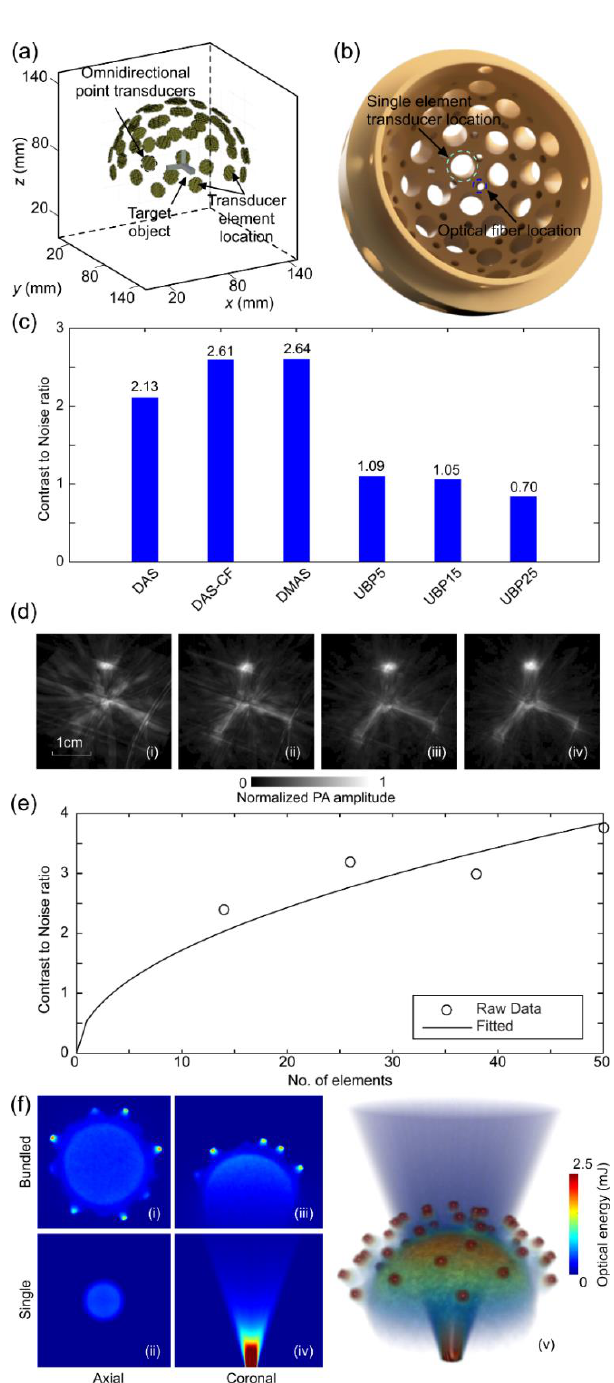
Figure 1. Simulation results. ( a ) Simulated configuration of 50 equidistant transducers on a 12 cm diameter hemisphere using k-Wave toolbox for imaging a three-leg phantom; ( b ) bottom view of the 3D model of 50 element hemisphere cap using Fusion 360 software; ( c ) image quality assessment in terms of contrast to noise ratio when different image reconstruction algorithms were used for reconstruction of the three-leg phantom in a 50-element PACT; Delay-and-Sum, Delay-and-Sum Coherence Factor, Delay-Multiply-and-Sum, and Universal Back Projection with 5, 15, and 25 MHz cutoff frequencies; ( d ) (i – iv) reconstructed images using 14, 26, 38, and 50 equidistant 12.7 mm transducers; for image reconstruction, DMAS algorithm was used; ( e ) quantitative evaluation of reconstructed images in terms of contrast to noise ratio with square root function fit; ( f ) fluence map of full-field and overhead configurations in the axial (i,ii) and coronal plane (iii,iv), and (v) comparison of fluence homogeneity for full-field and overhead configurations.